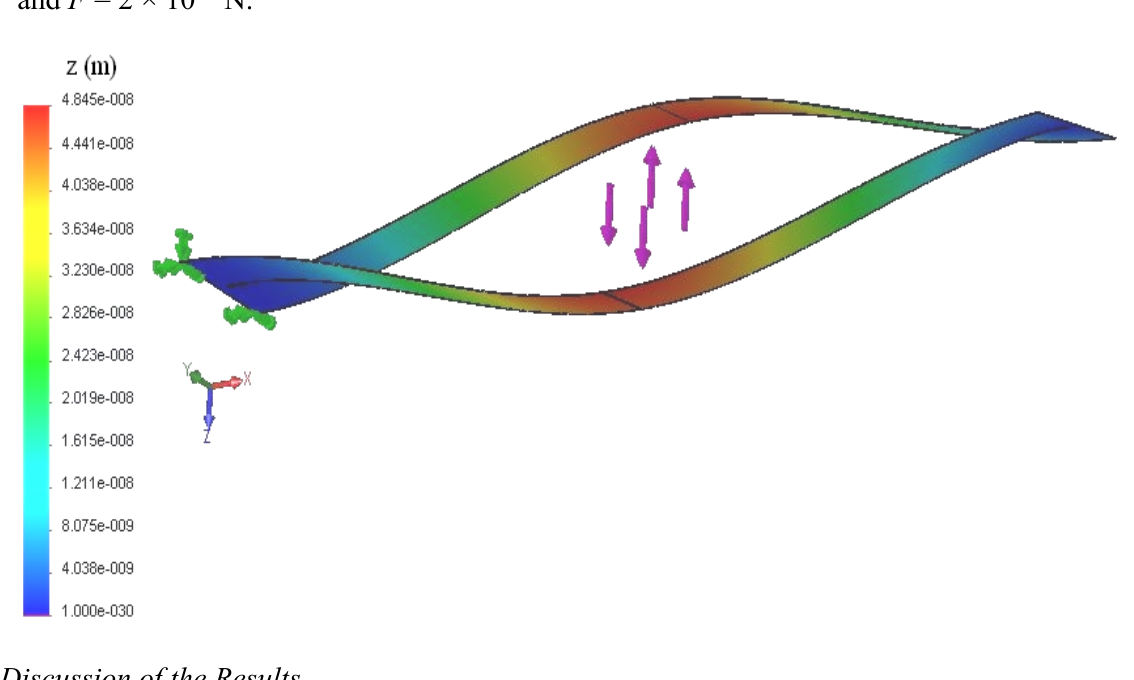
Figure 3. Deflection profile for rectangular microcantilever with long-slit with L L = 415 μ m, W = 60 μ m, d = 0.4 μ m, c = 5 μ m, δ = 2 μ m, E = 0.1124 N μ m − 2 , v = 0.28, and F = 2 × 10 − 9